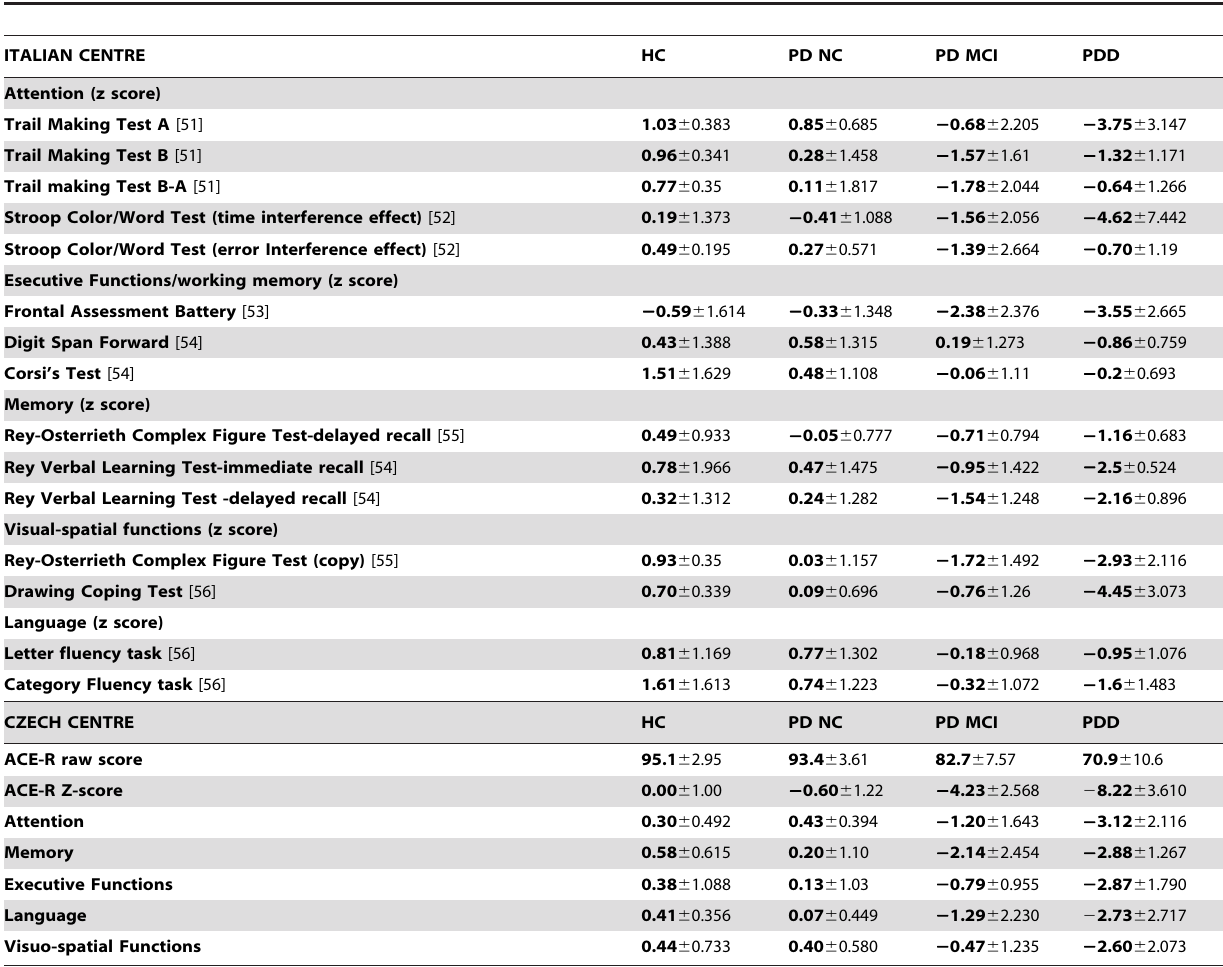
Table 2. Cognitive